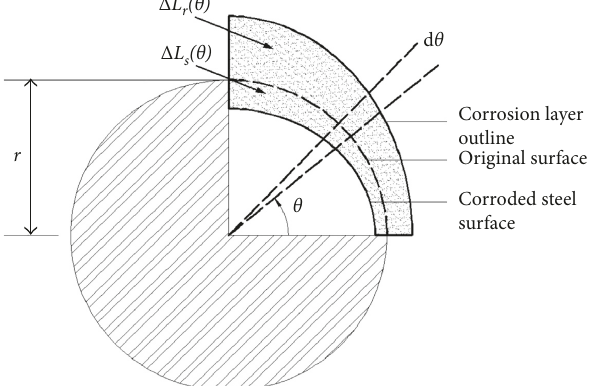
Figure 1: Oval rust expansion displacement theoretical